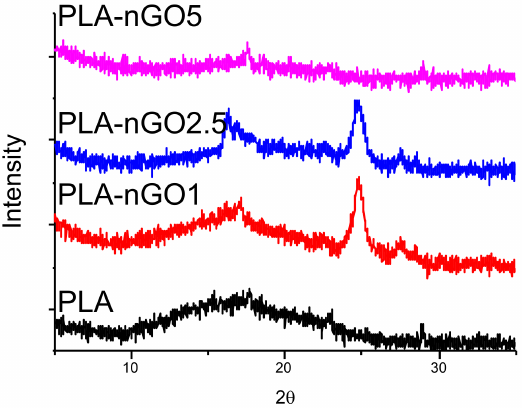
Figure 3. XRD spectra of PLA, PLA-nGO1, PLA-nGO2.5, and PLA-nGO5